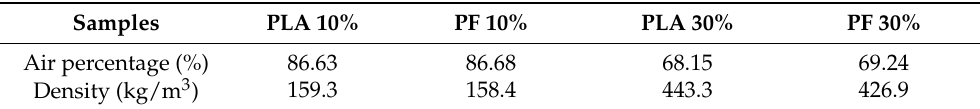
Table 3. Densities and air content of the studied